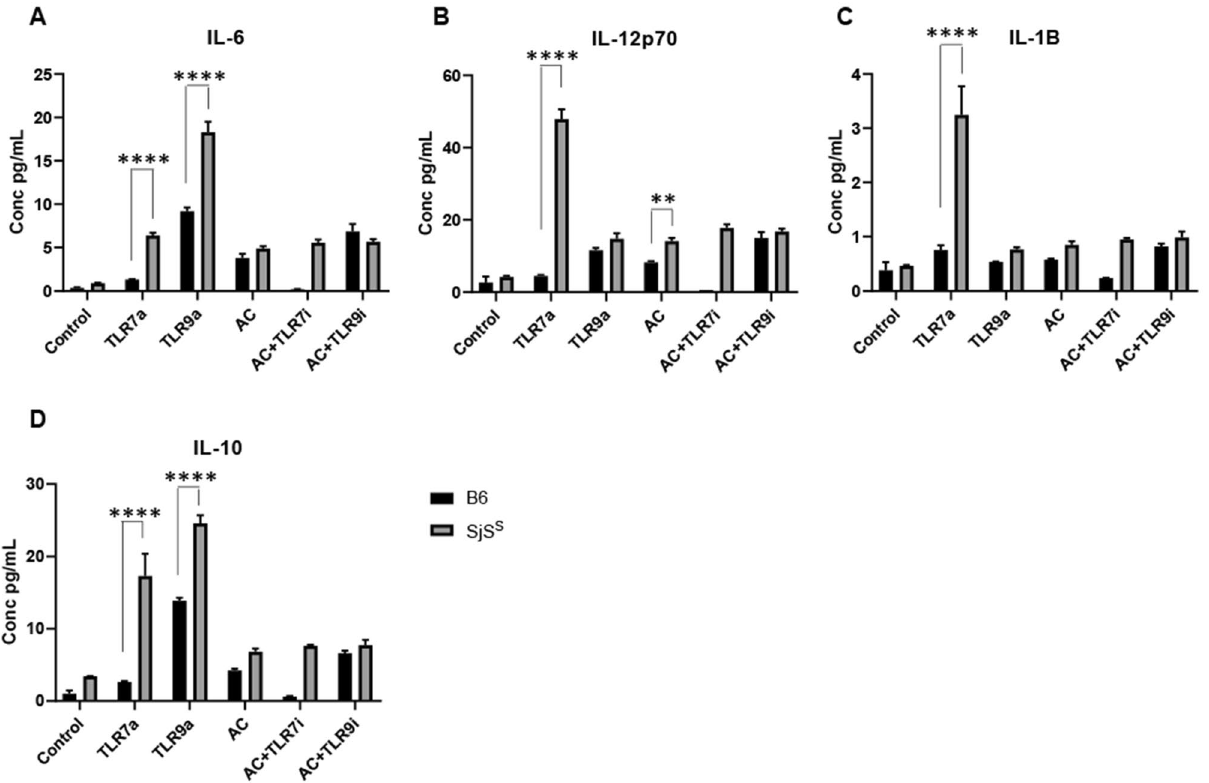
Figure 5. SjS S BMDMs produce increased inflammatory cytokines in response to TLR stimuli. In Fig. 4 BMDMs from B6 (n = 3 mice) and SjS S (n = 3 mice) mice were treated with TLR7a (imiquimod) and TLR9a (CpG) to stimulate inflammation, AC, or AC plus TLR7i (ODN 20958), or AC plus TLR9i (ODN 4084-F) to inhibit TLR7 and 9 driven inflammation. Cell culture supernatant was collected after a three hour incubation following conclusion of treatment and wash. ( A–D) Cell culture supernatant was evaluated for cytokines with a Bio-Plex assay as performed in Fig. 3. The statistical significance was calculated by two-tailed unpaired t -tests where error bars indicate SEM ** p < 0.01, and **** p <